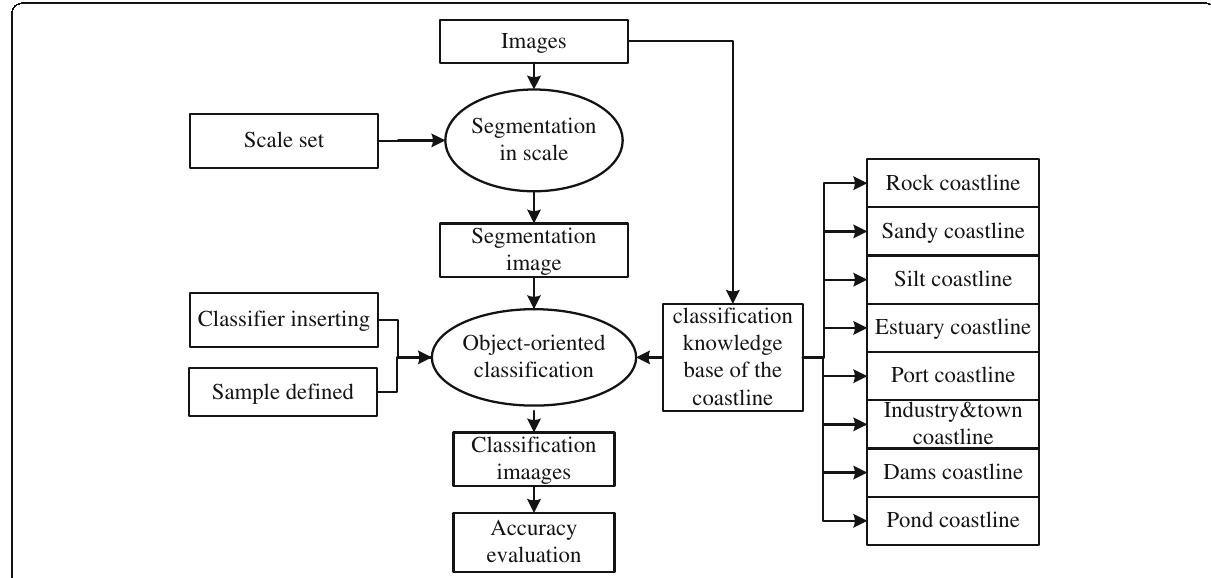
Fig. 2 Technique flow chart of object-oriented image classification for